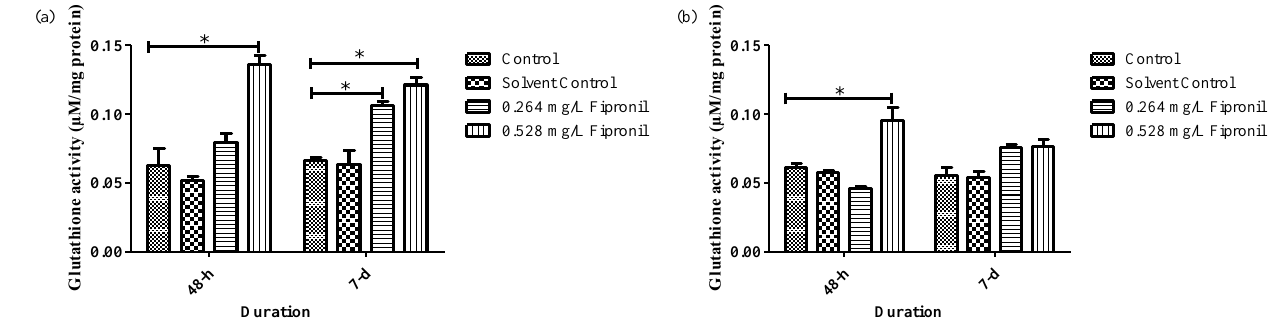
Figure 3. The glutathione activities (mean ± SEM) of ( a ) the digestive gland and ( b ) the gill tissues of freshwater mussels. * indicates p < 0.05.